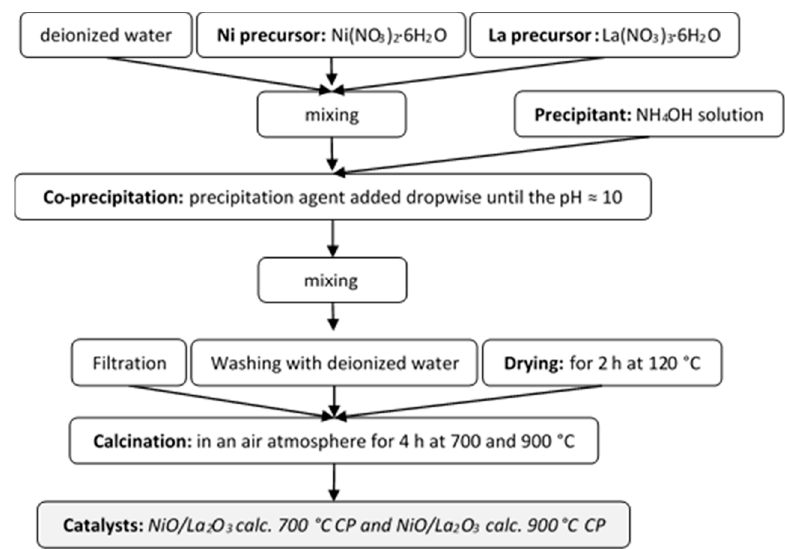
Figure 8. Synthesis diagram of NiO/La 2 O 3 CP catalysts calcined in air atmosphere for 4 h at 700 °C and 900 °C.